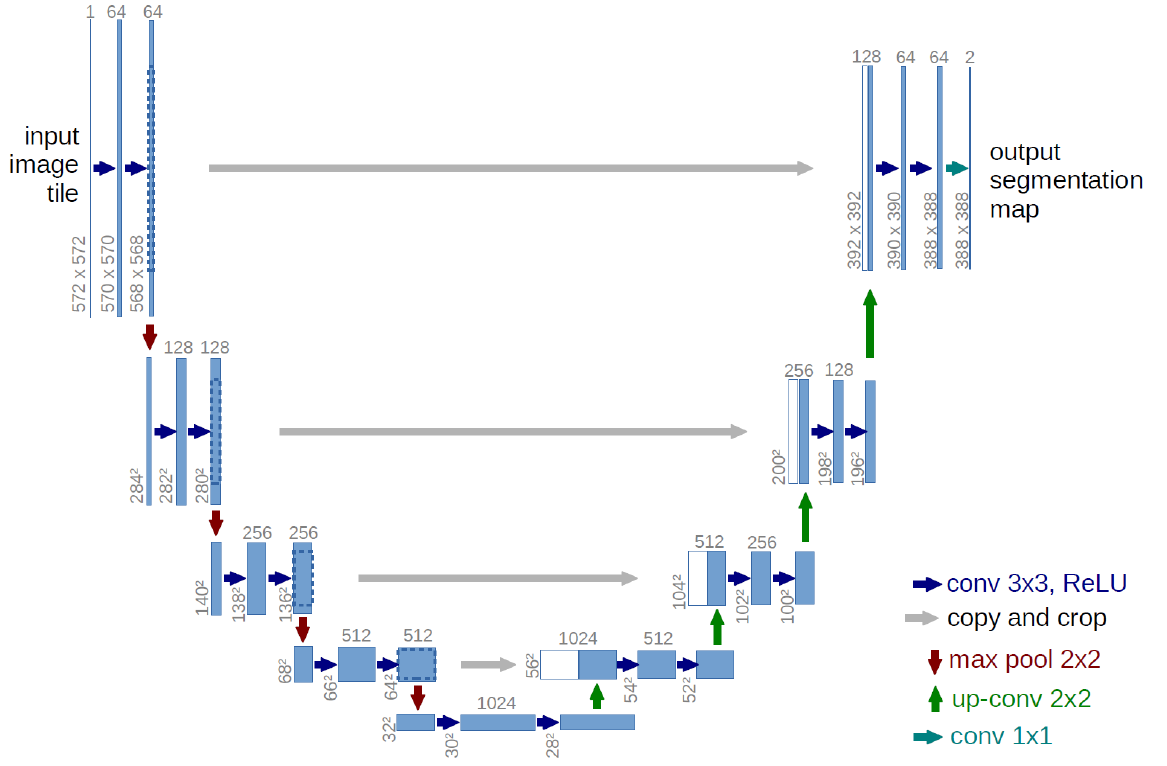
Figure 2. The U-Net architecture [37]. In the contraction path of this network, feature channels are doubled in each down-sampling. Conversely, the expansion path is responsible for decreasing feature channels. The skip connections are also displayed with gray arrows drawn to incorporate two feature maps.